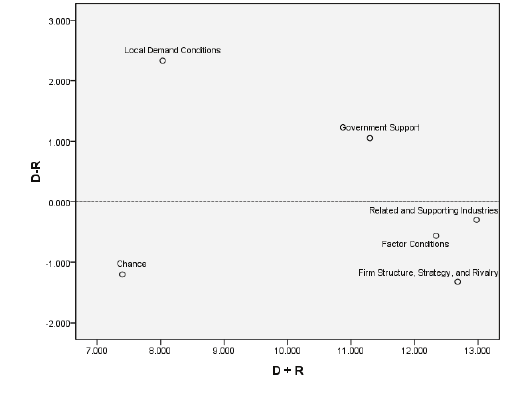
Figure2 Impact-relationship